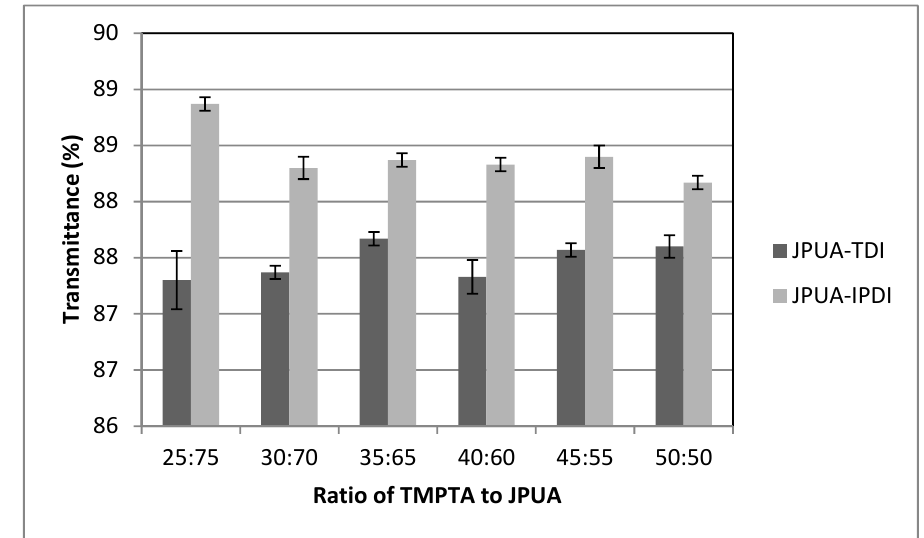
Figure 8. Transmittance value for variation of JPUA-TDI and JPUA-IPDI films.